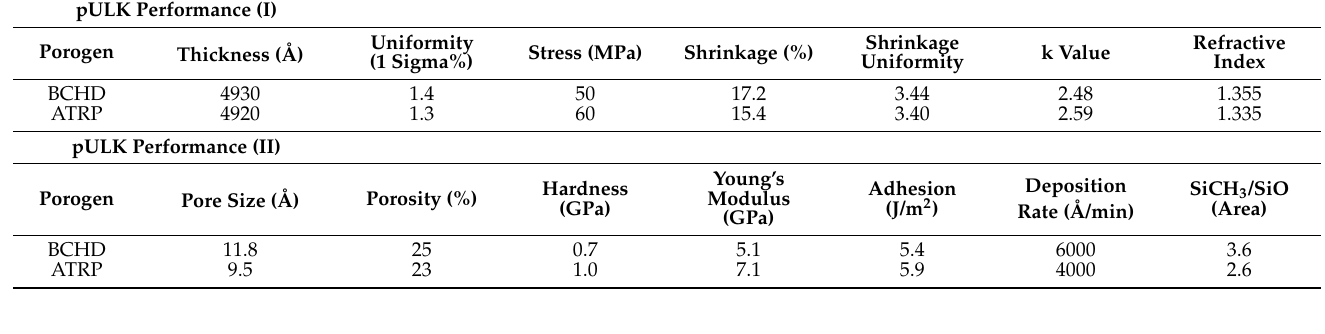
Table 7. Performances of pULK dielectric films from DEMS with ATRP and BCHD [25].